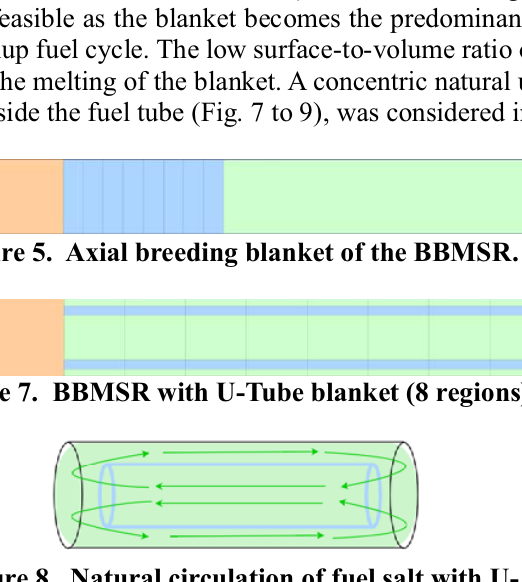
Figure 9. Top view U-Tube BBMSR